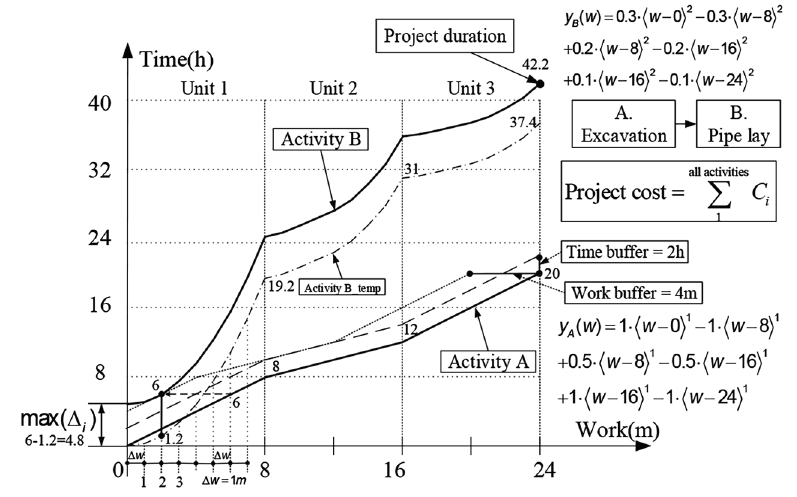
Figure 5. Example schedule with singularity